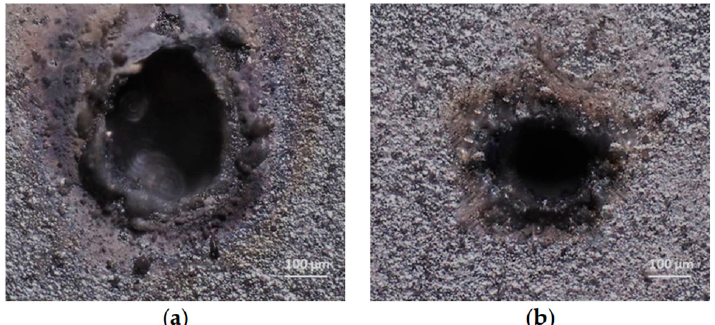
Figure 8. Micromachined cavities in smart ceramic materials using ( a ) in air and ( b ) underwater. Reprinted from [42], with permission from MDPI journals.